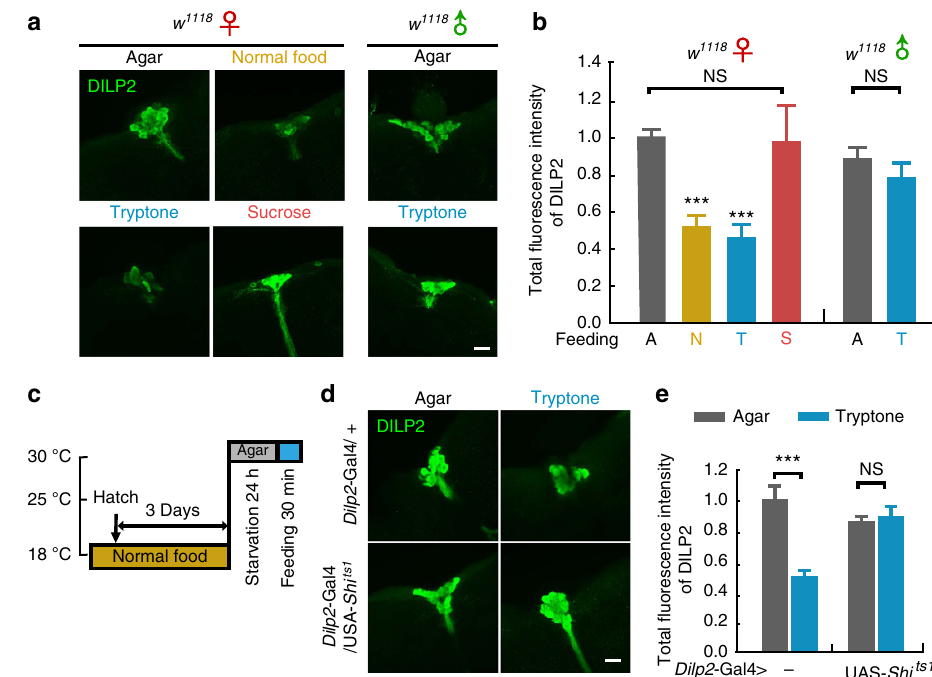
Figure 6 | Protein intake induces significant DILP2 release in IPCs. ( a , b ) Tryptone feeding resulted in a significant decrease of DILP2 signals in female but not male flies. Representive images of DILP2 immunostaining in IPCs after 30min feeding of different types of food and its quantification data are shown. n ¼ 7–49 for female groups, n ¼ 18–23 for male groups. Scale bar, 20 m m. P (Food*Sex) ¼ 4.40E-3 (two-way ANOVA, Bonferroni test). ( c ) Diagram of temperature induction for blocking the secretion of IPCs using Dilp2 -Gal4 4 UAS- Shi ts1 flies. ( d , e ) Tryptone feeding induced a significant reduction in DILP2 staining signals, which was absent in flies with deficient secretion in IPCs. n ¼ 12–16. Scale bar, 20 m m. P (Food*Genotype) ¼ 1.23E-3 (two-way ANOVA, Bonferroni test). *** P o 0.001. NS indicates no statistical significance. The data are mean ±